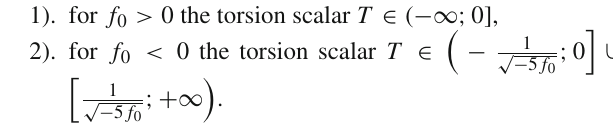
, w = 2 , K = 1. The 12 3